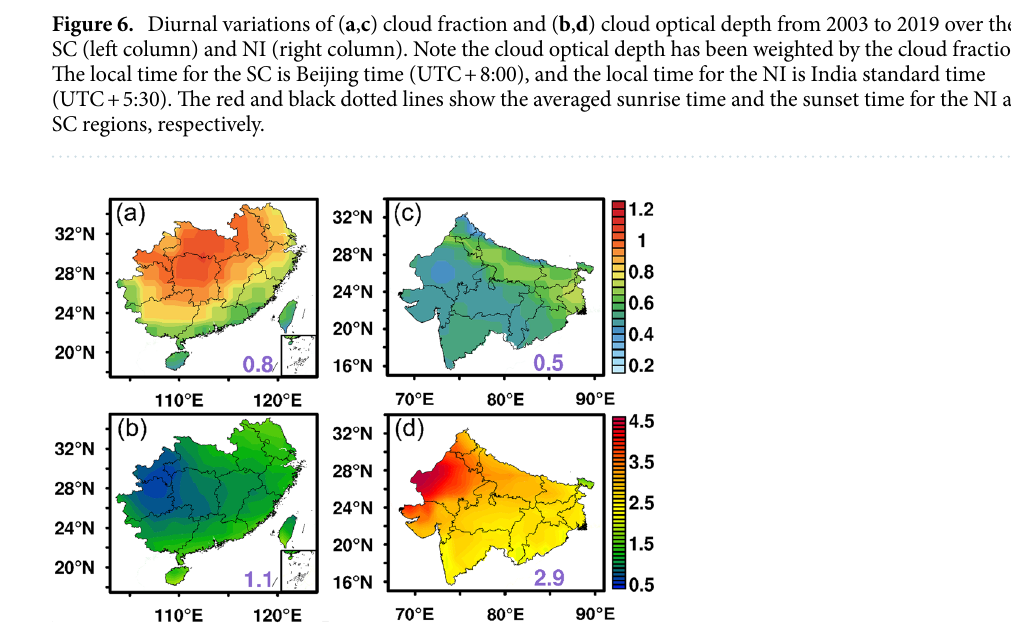
Figure 7. Annual averaged ( a , c ) AOD and ( b , d ) aerosol effect efficiency (Unit: kWh/m 2 /d/τ) from 2003 to 2019 over the SC and NI. The map was generated by ESRI ArcGIS 10.5 software available at the ESRI website (https:// www. esri. com/ en- us/ arcgis/ produ cts/ arcgis- platf orm/ overv iew). The administrative boundary shapefile for southern China is available at the RESDC website (https:// www. resdc. cn/) and the administrative boundary shapefile for northern India is available at the GADM website (https:// gadm. org/ downl oad_ count ry.